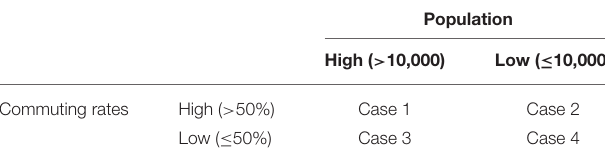
TABLE 1 | CSD identification typology.